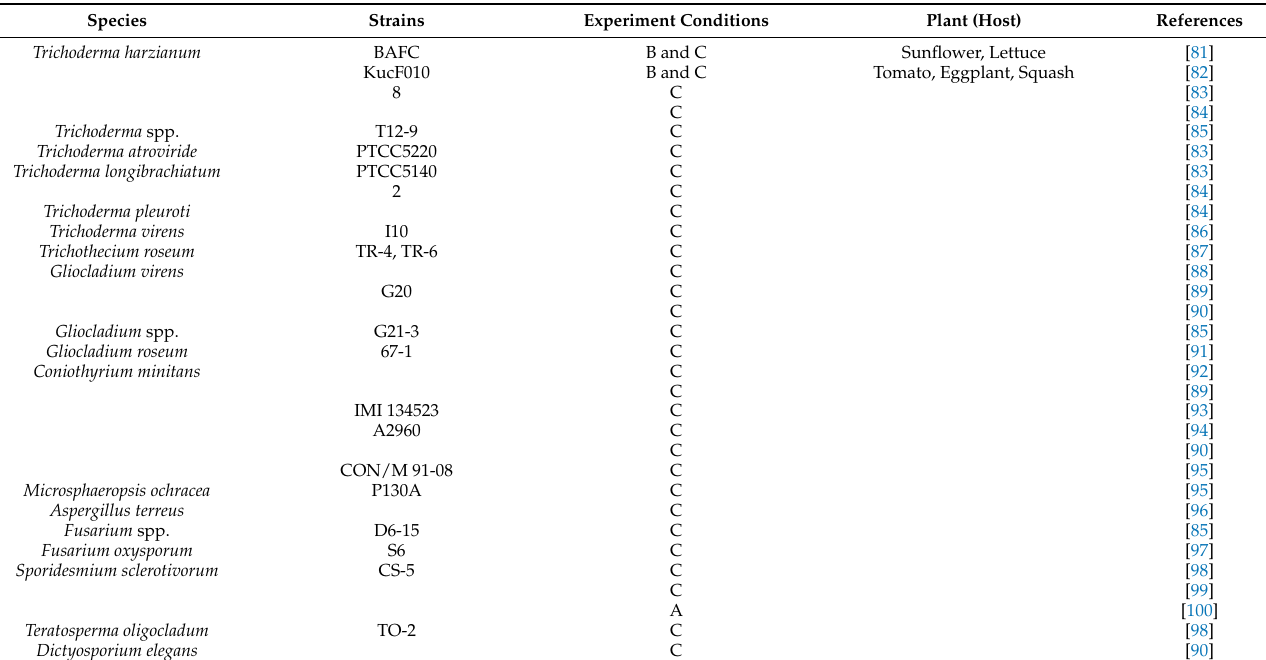
Table 3. Microbial strains inhibiting S. sclerotiorum with mycoparasitism through microscopy. Species Strains Experiment Conditions Plant